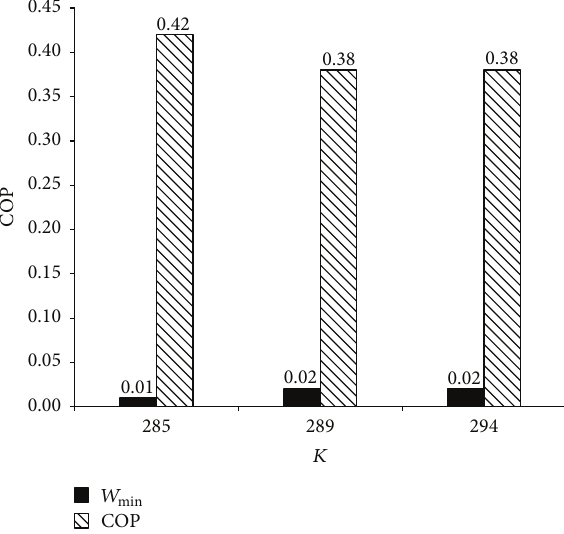
Figure 9: Effect of condenser temperature on 𝑊 min and